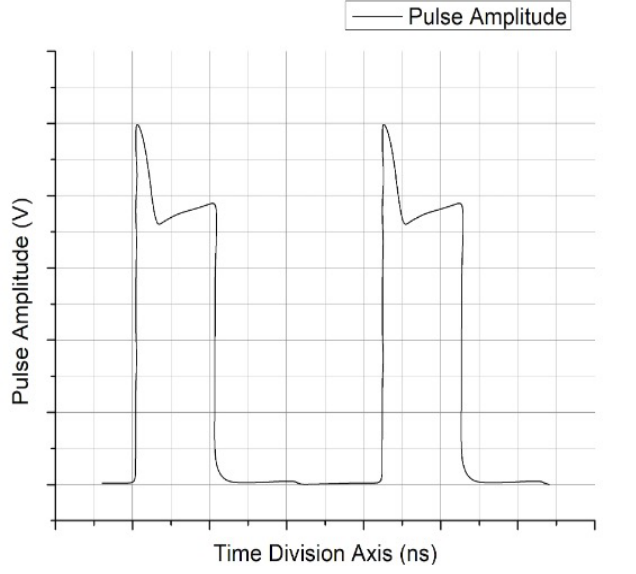
Figure 12. Output voltage waveform obtained from the